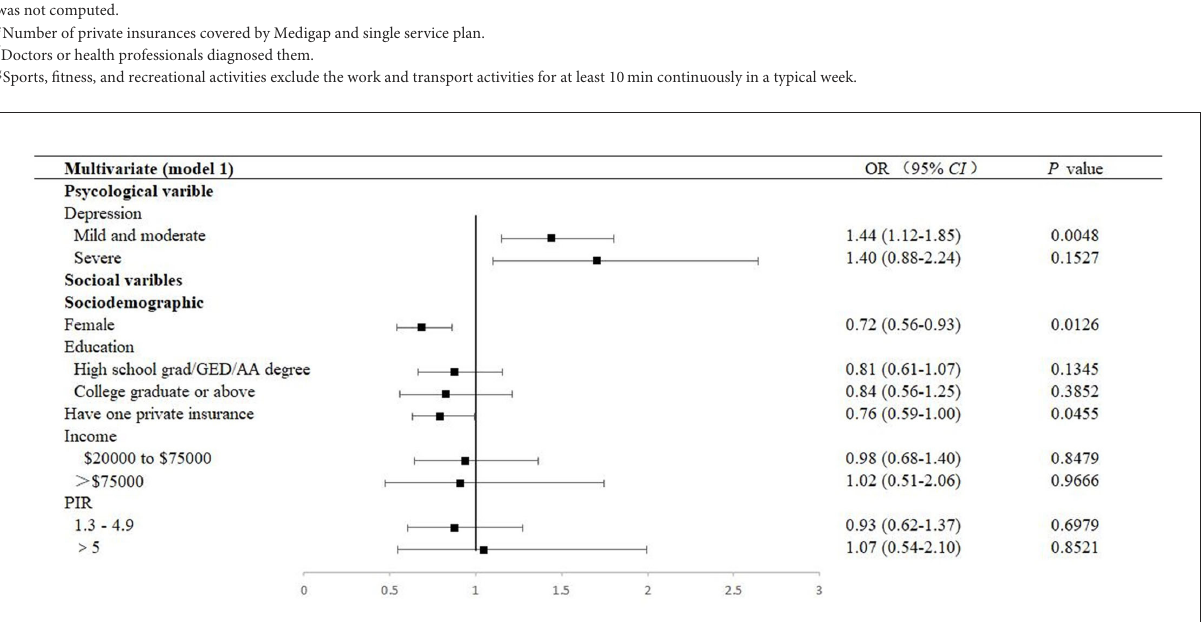
FIGURE2 Multivariable forest plot of the association between factors and DR (Model 1). Model 1 was performed by adjusting sociodemographic variables. DR, diabetic retinopathy; OR, odds ratios; CI, confidence interval; GED, General Educational Development; AA, Associate of Arts; PIR, Ratio of family income to the poverty level, PIR was calculated by dividing family income by the poverty guidelines specific to the survey year, and the respondent only reported income as < $20,000 or ≥ $20,000, the value was not